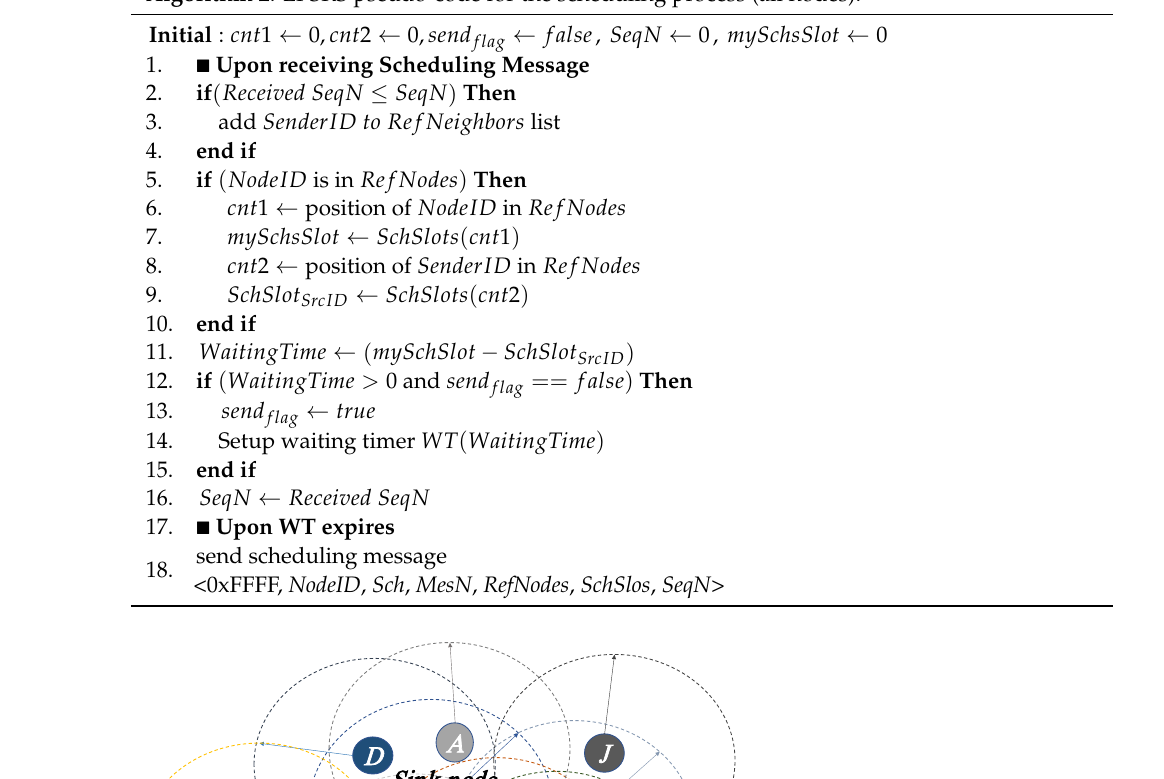
Algorithm 2 : LPSRS pseudo-code for the scheduling process (all nodes).